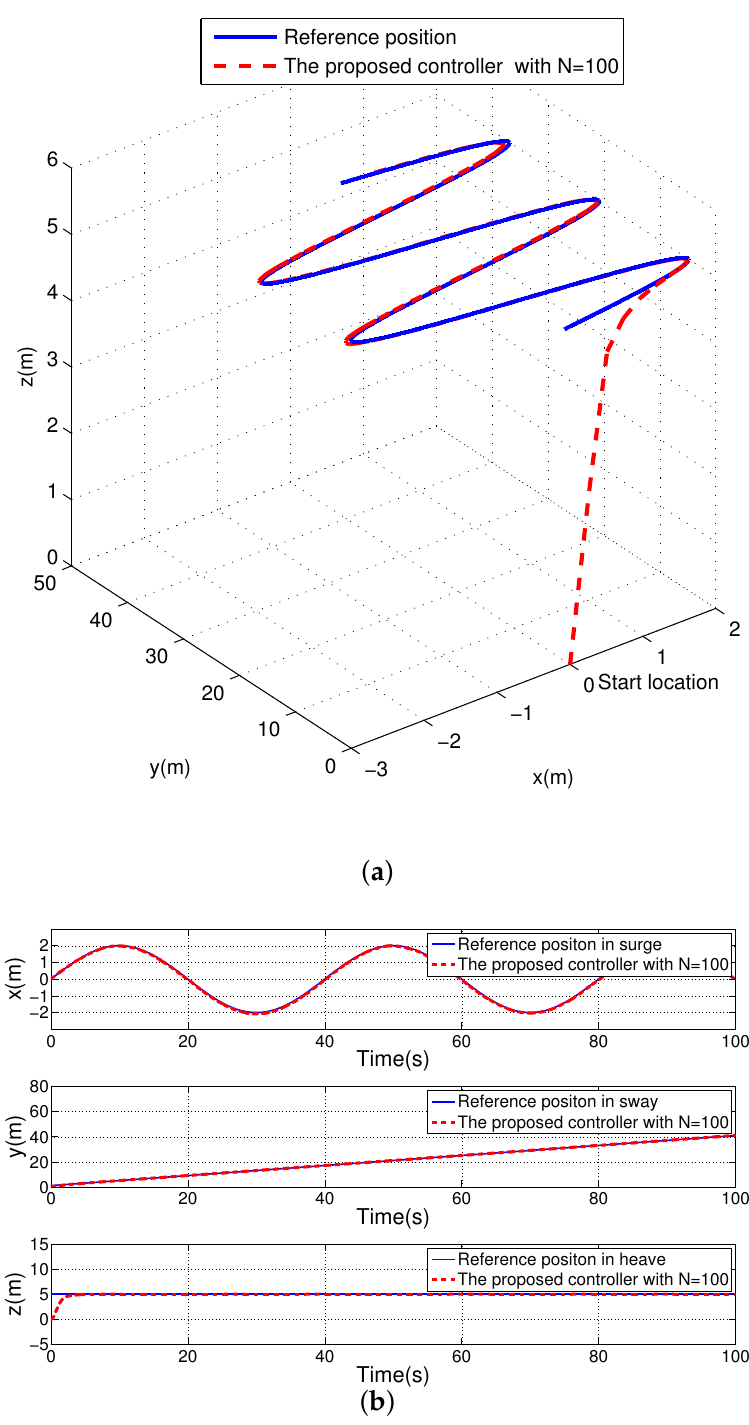
Figure 4. AUV position tracking for noise case 1 (T = 0.01 s and N = 100): ( a ) 3D position tracking and ( b ) tracking in surge, sway, and heave.